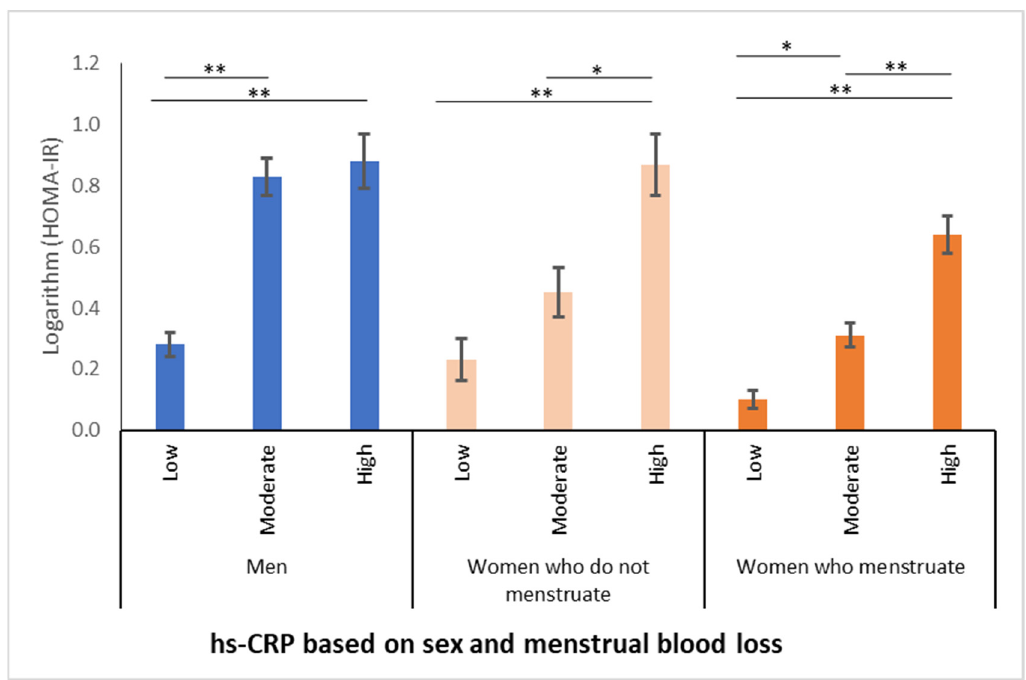
Figure 4. Relationship between homeostatic model assessment-insulin resistance (HOMA-IR) values and degrees of inflammation in men and women (all eating habits grouped). * p ≤ 0.001; ** p < 0.0001. Data expressed on the logarithmic scale.